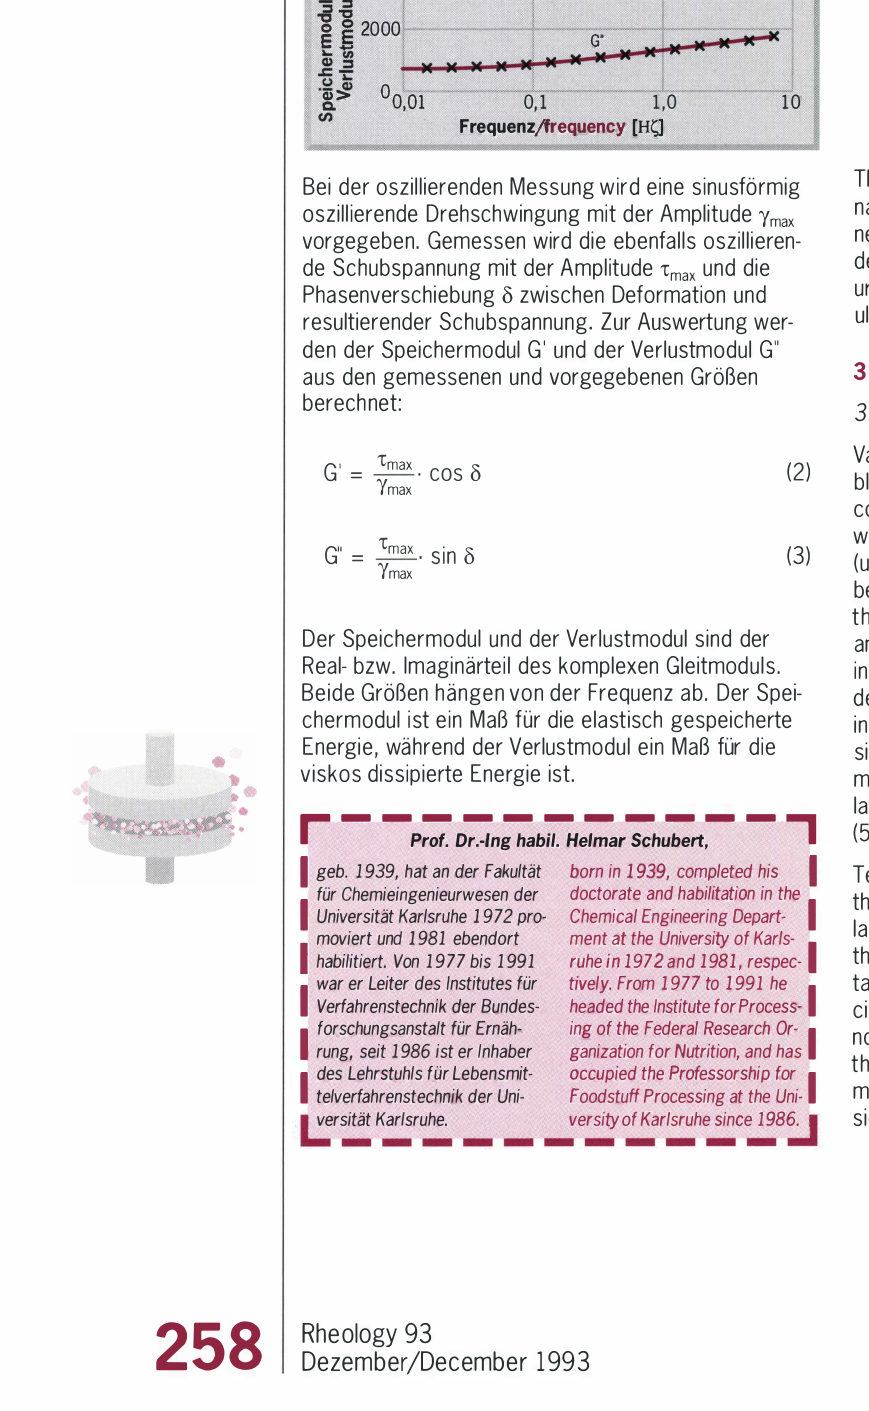
Frequenzverlauf. Oszillationsamplitude 1 1o-3 · Fig. 2: Dynamic measurements as a function of frequency at a strain amplitude of 1 ·